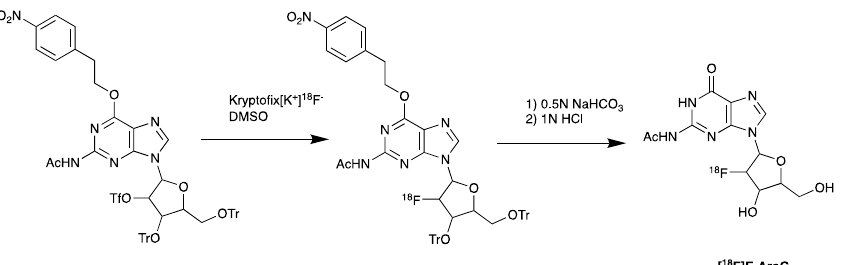
Figure 8. Synthesis of [ 18 F]AraG, starting with nucleophilic fluorination of the protected precursor, followed by acid deprotection.